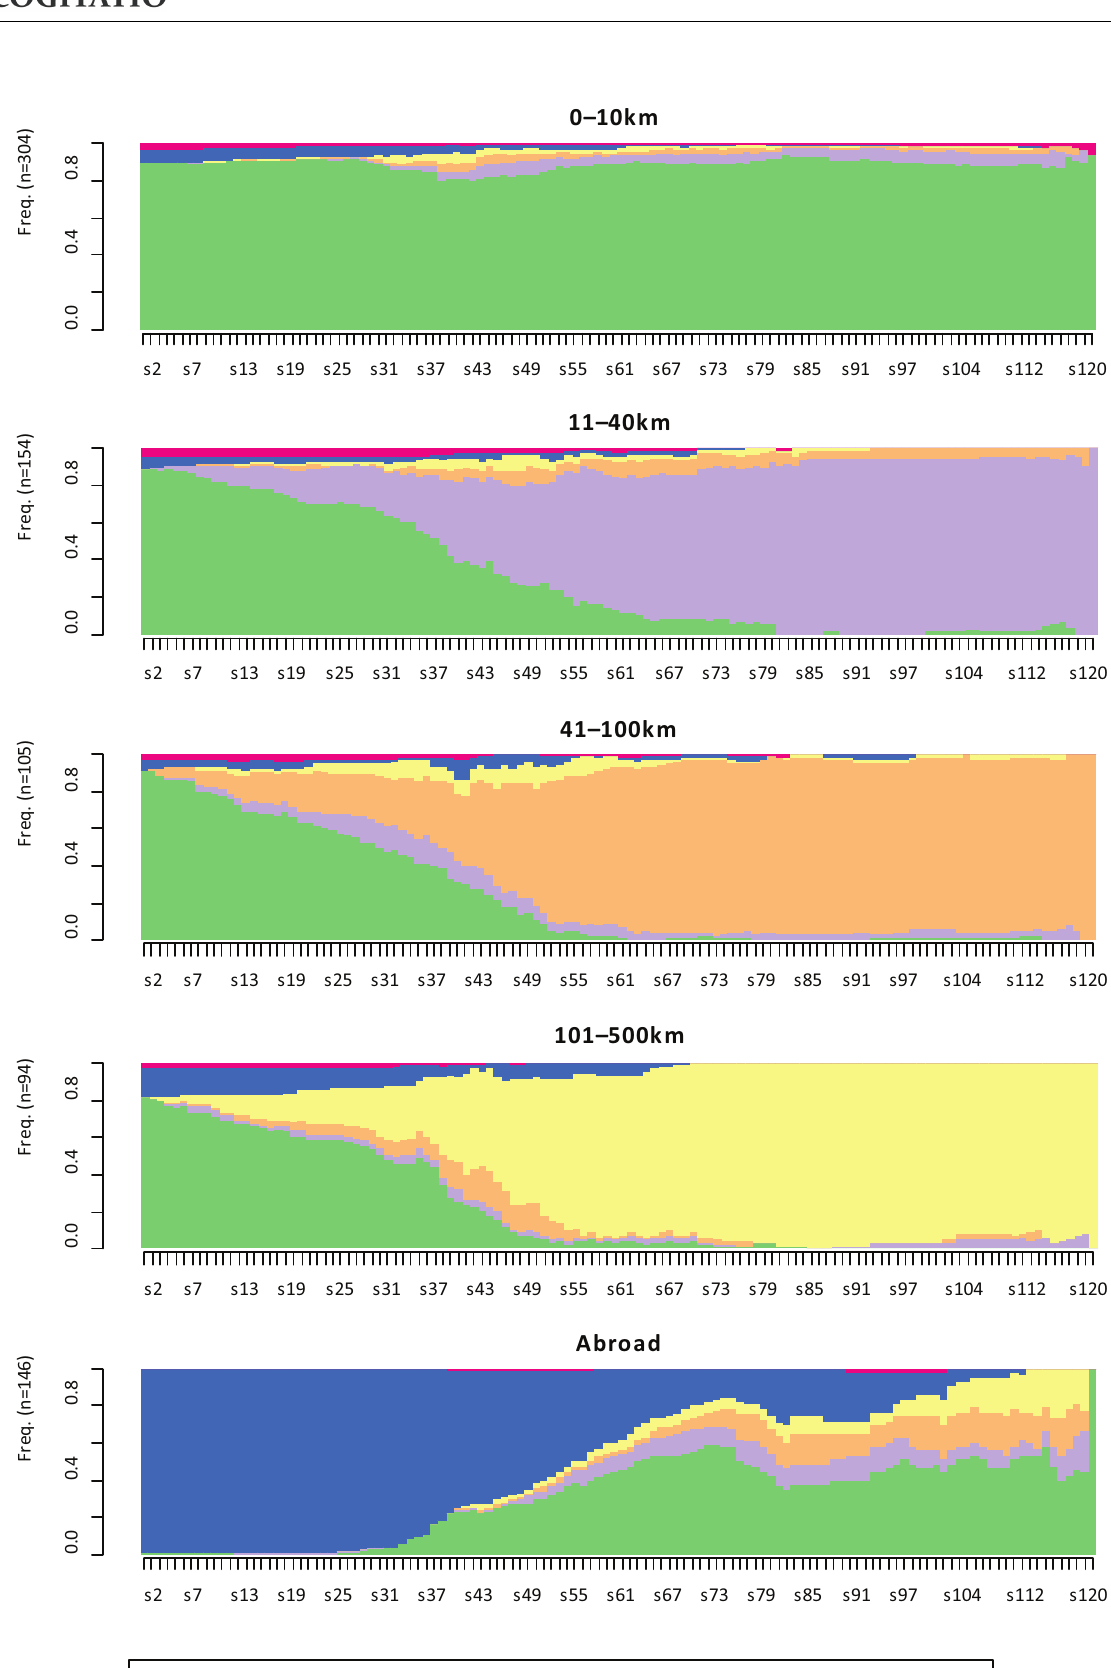
Figure 3. Typology of migration